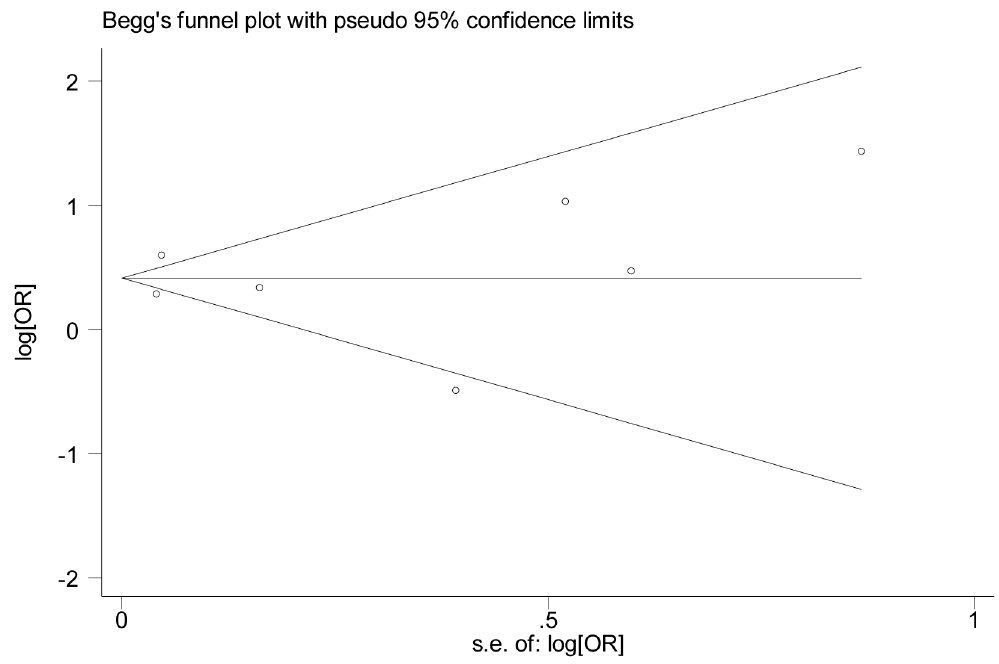
Figure 4. Funnel plot of the case-control studies evaluating the association between DM and POAG. Begg’s regression asymmetry test ( P =0.548). OR=odds ratio; DM=diabetes mellitus; POAG=primary open-angle glaucoma.